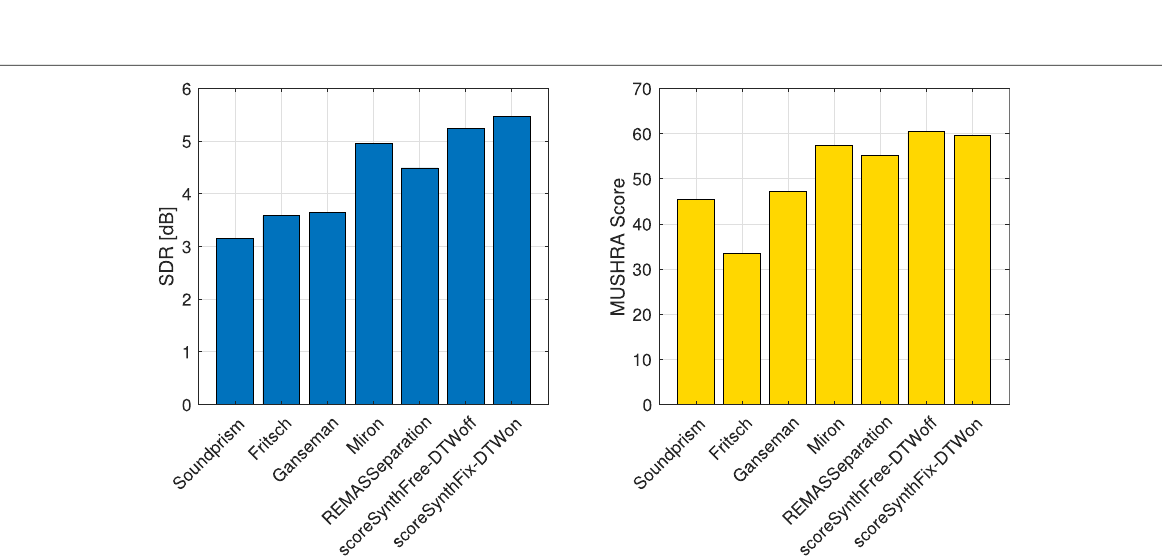
Fig. 11 Comparison between the MUSHRA results and SDR for all the all compared methods in Section